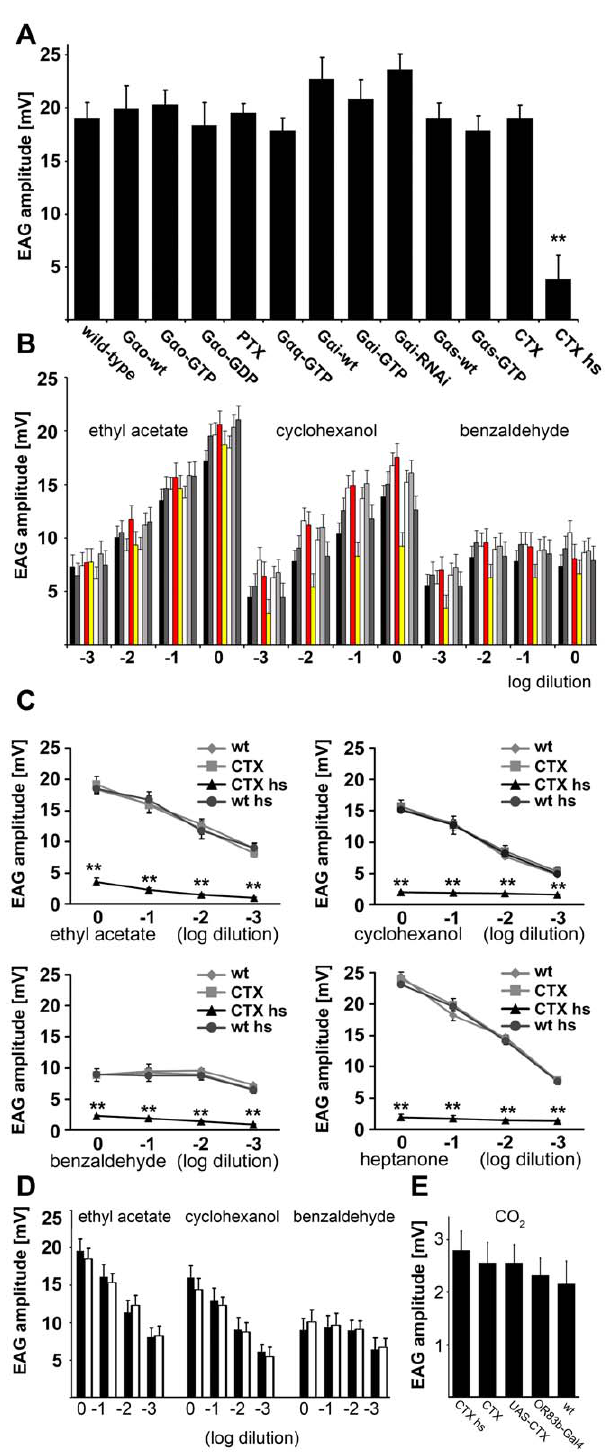
Figure 1. Screening G-proteins for participation in olfactory signal transduction. ( A ) UAS constructs of different G a -proteins, mutated G a -proteins and G-protein affecting toxins were expressed in the sensory neurons of the third antennal segment using an Or83b-Gal4 driver line, last bars present heat shocked Or83b-Gal4;UAS-CTX flies (CTX hs) and Or83b-Gal4;UAS-CTX flies without heat shock (CTX). EAG amplitudes in response to application of undiluted ethyl acetate were recorded (n . 10 flies were recorded). The difference between wt and heat shocked CTX flies was statistically checked by the